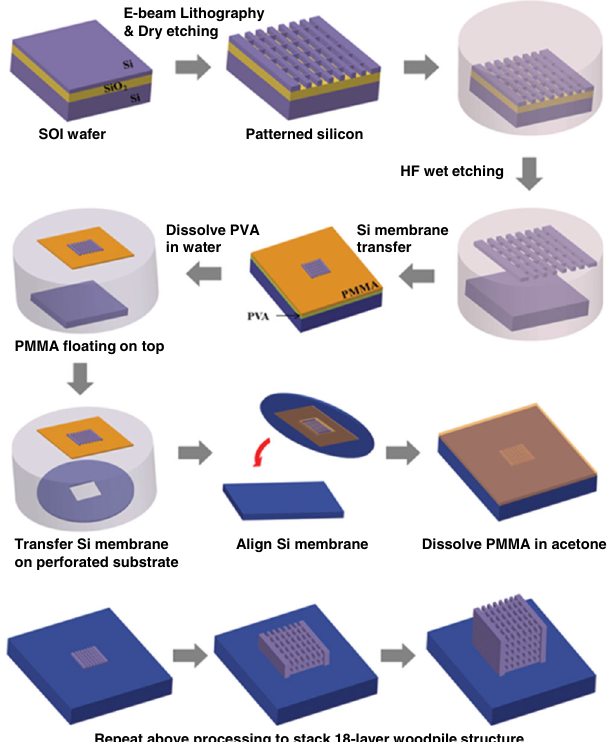
FIG. 11. Schematic representation of the silicon membrane transfer method to stack multiple woodpile layers.